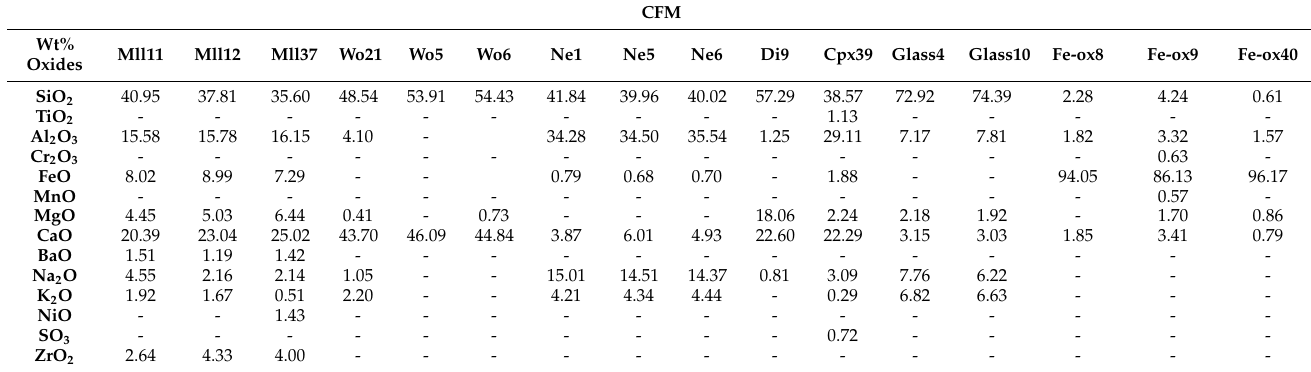
Table 3. Representative EDS composition (wt%) of main mineralogical phases identified in sample CFM. Wo: wollastonite; Di: diopside; Cpx: clinopyroxene; Mll: melilite; Fe-Ox: iron oxide.;